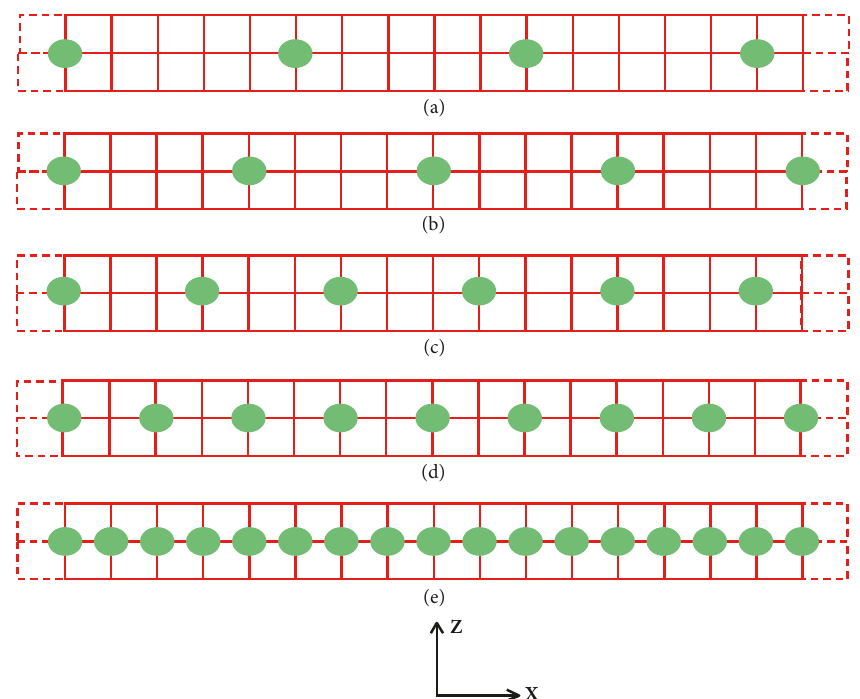
Figure 2: Distributions of the grafting points of the systems containing chains numbersof 52(a),64(b), 84(c), 128(d), and 252(e), respectively, in the surfaces of the nanorod. The green dot represents the grafted point. The dashed areas on both sides of the rectangles denote the rest parts of the